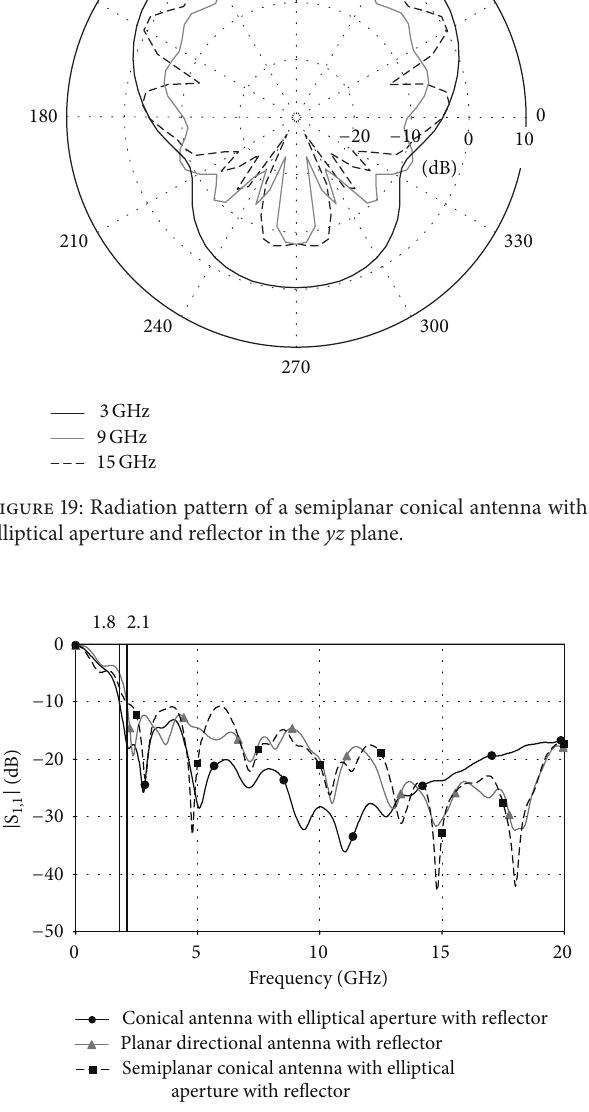
Figure 20: Reflection coefficient magnitude from volumetric to planar antenna